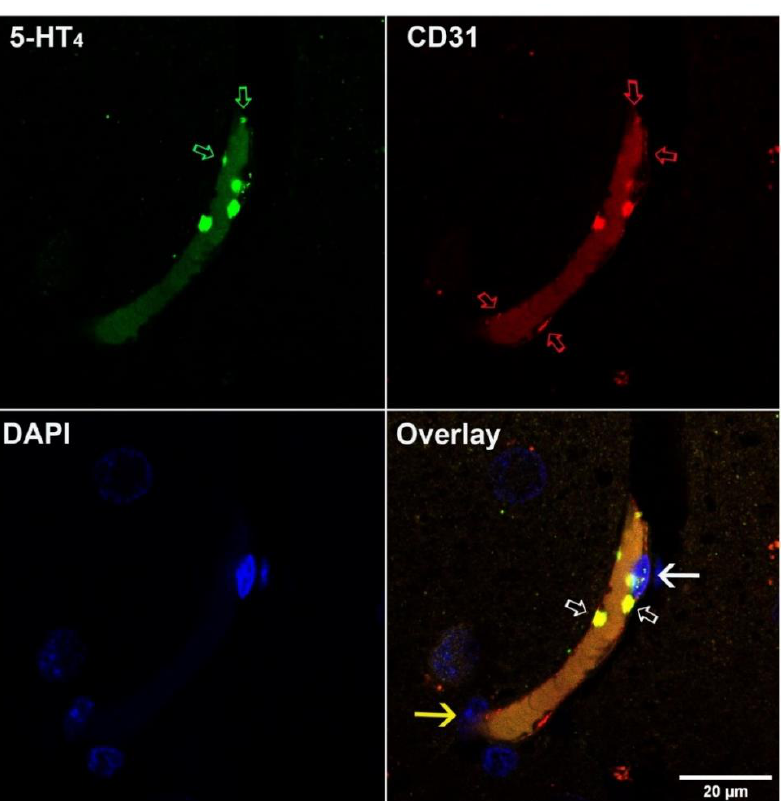
Figure 1. Photomicrograph illustration of 5-HT 4 receptor immunohistochemistry analysis in human brain ( a ) shows capil- lary vessels stained with 5-HT 4 receptor antibody in the basal cortex and ( b ) in hippocampus. A 5-HT 4 labeling is present on endothelial cells of capillary vessels (  ) and neurons (  ).